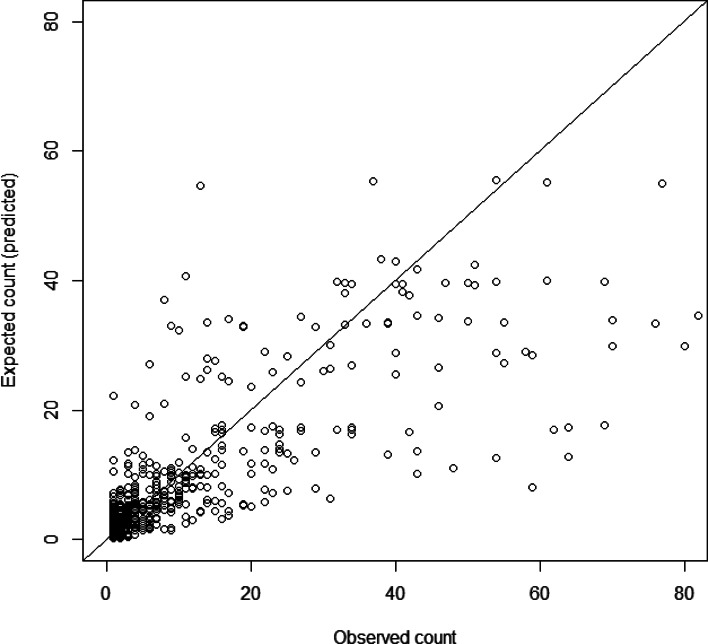
Plot of observed and expected (predicted) non-zero cases.